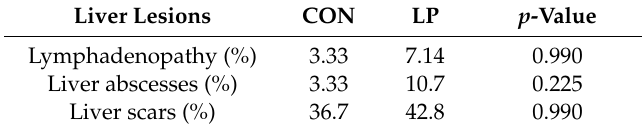
Table 7. The e ff ects of high protein (CON) and low protein (LP) diets on liver